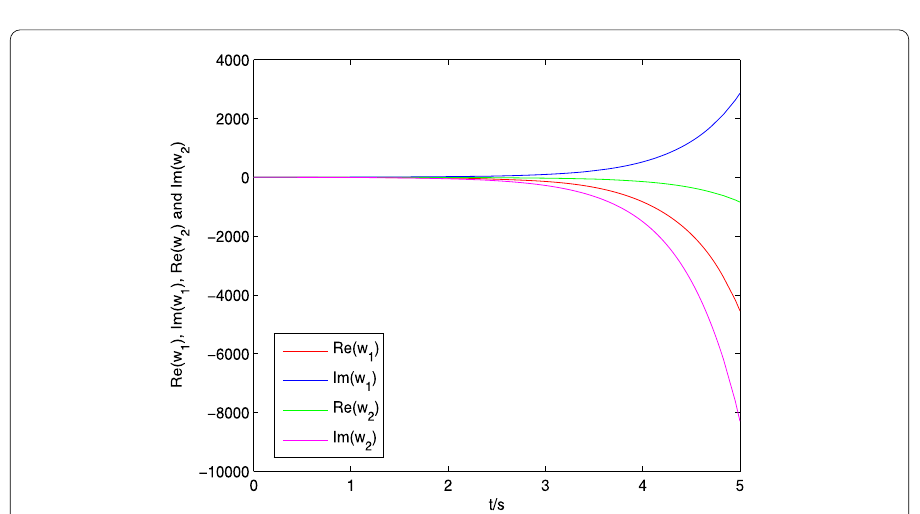
Figure 4 Time responses for the real and imaginary parts of the state solution in Example 2 without control